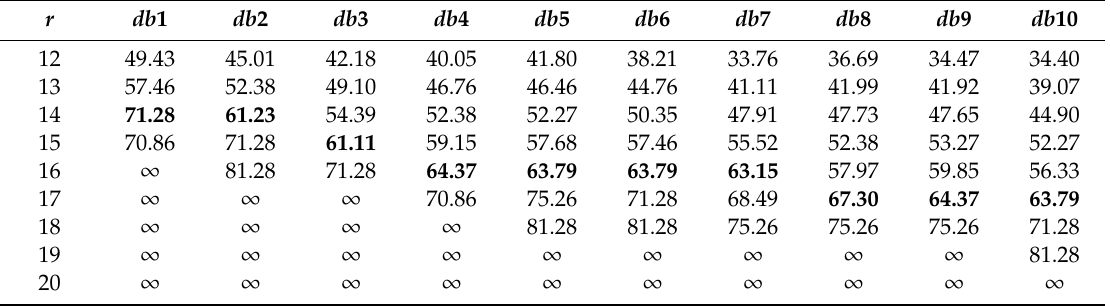
Table 2. Calculation results ( PSNR , dB) of 3D medical images (with 12 BPC) DWT by using bit-width r of Daubechies wavelets filters coe ffi